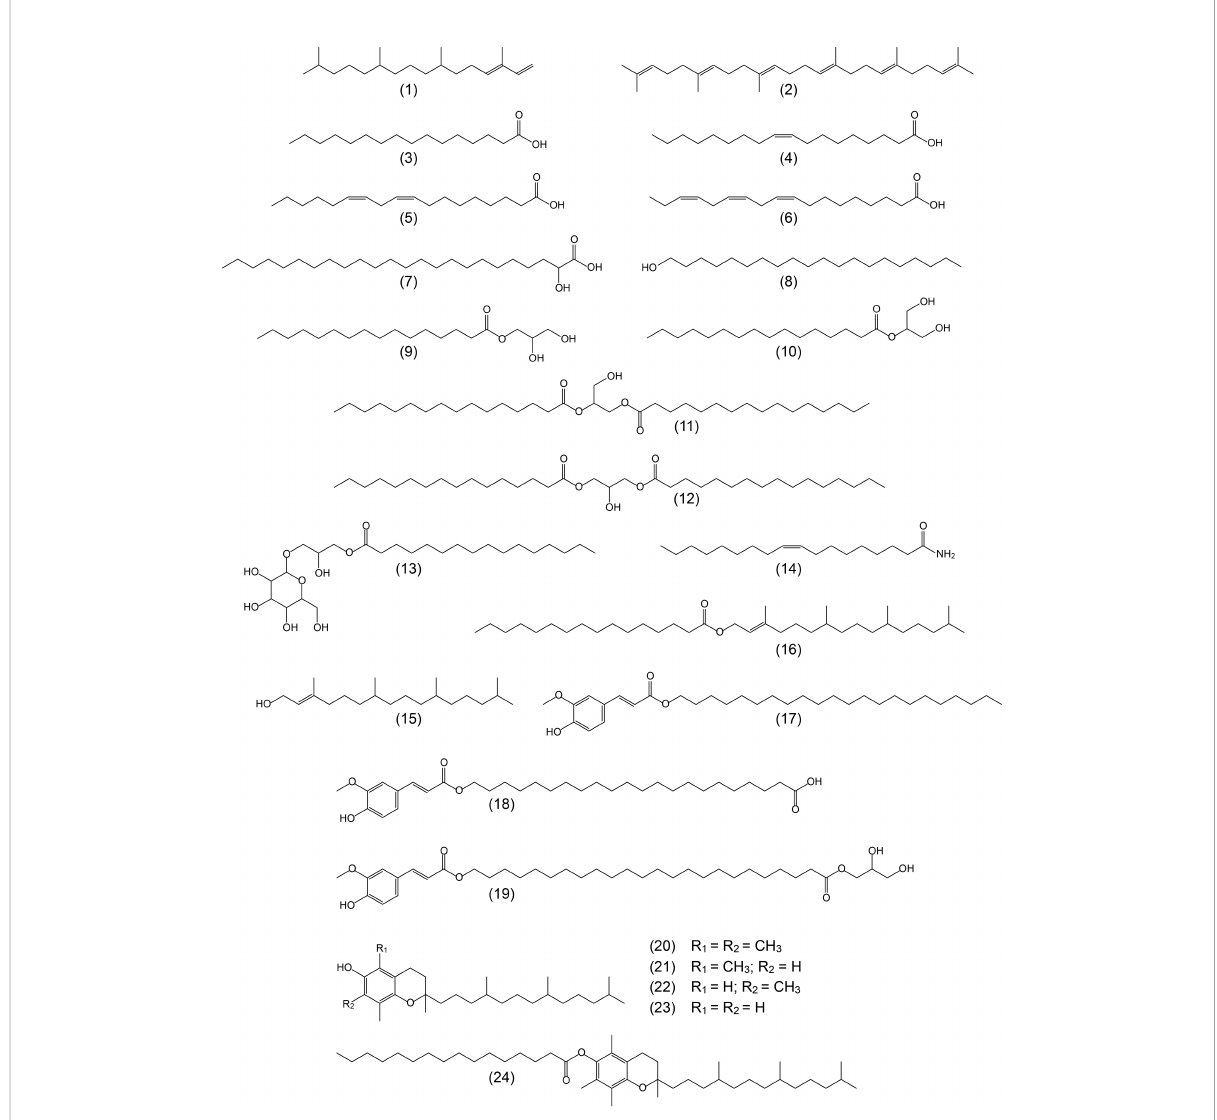
FIGURE 3 Structures representative of the main aliphatic compounds, ferulic acid derivatives, and tocopherols identi fi ed in the acetone extracts of the rind and pith of papyrus stems and referred in the text. 1: phytadiene; 2: squalene; 3: n -hexadecanoic (palmitic) acid; 4: cis -octadec-9-enoic (oleic) acid; 5: cis , cis -octadeca-9,12-dienoic (linoleic) acid; 6: cis , cis,cis -octadeca-9,12,15-trienoic (linolenic) acid; 7: 2-hydroxytetracosanoic acid; 8: n -eicosanol; 9: 1-monohexadecanoylglycerol (1-monopalmitin); 10: 2-monohexadecanoylglycerol (2-monopalmitin); 11: 1,2-dipalmitin; 12: 1,3- dipalmitin; 13: lyso-monogalactosyl-monopalmitin; 14: oleic amide; 15: phytol; 16: phytyl hexadecanoate; 17: docosanyl ferulate; 18: feruloyloxydocosanoic acid; 19: 1-mono- trans -feruloyloxytetracosanoylglycerol; 20: a -tocopherol; 21: b -tocopherol; 22: g -tocopherol; 23: d - tocopherol; 24: a -tocopheryl